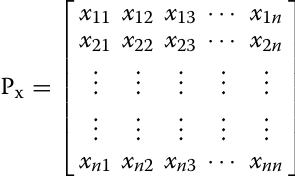
Where P x represents the pairwise comparison matrix, x nn is denoted the factors of P x .